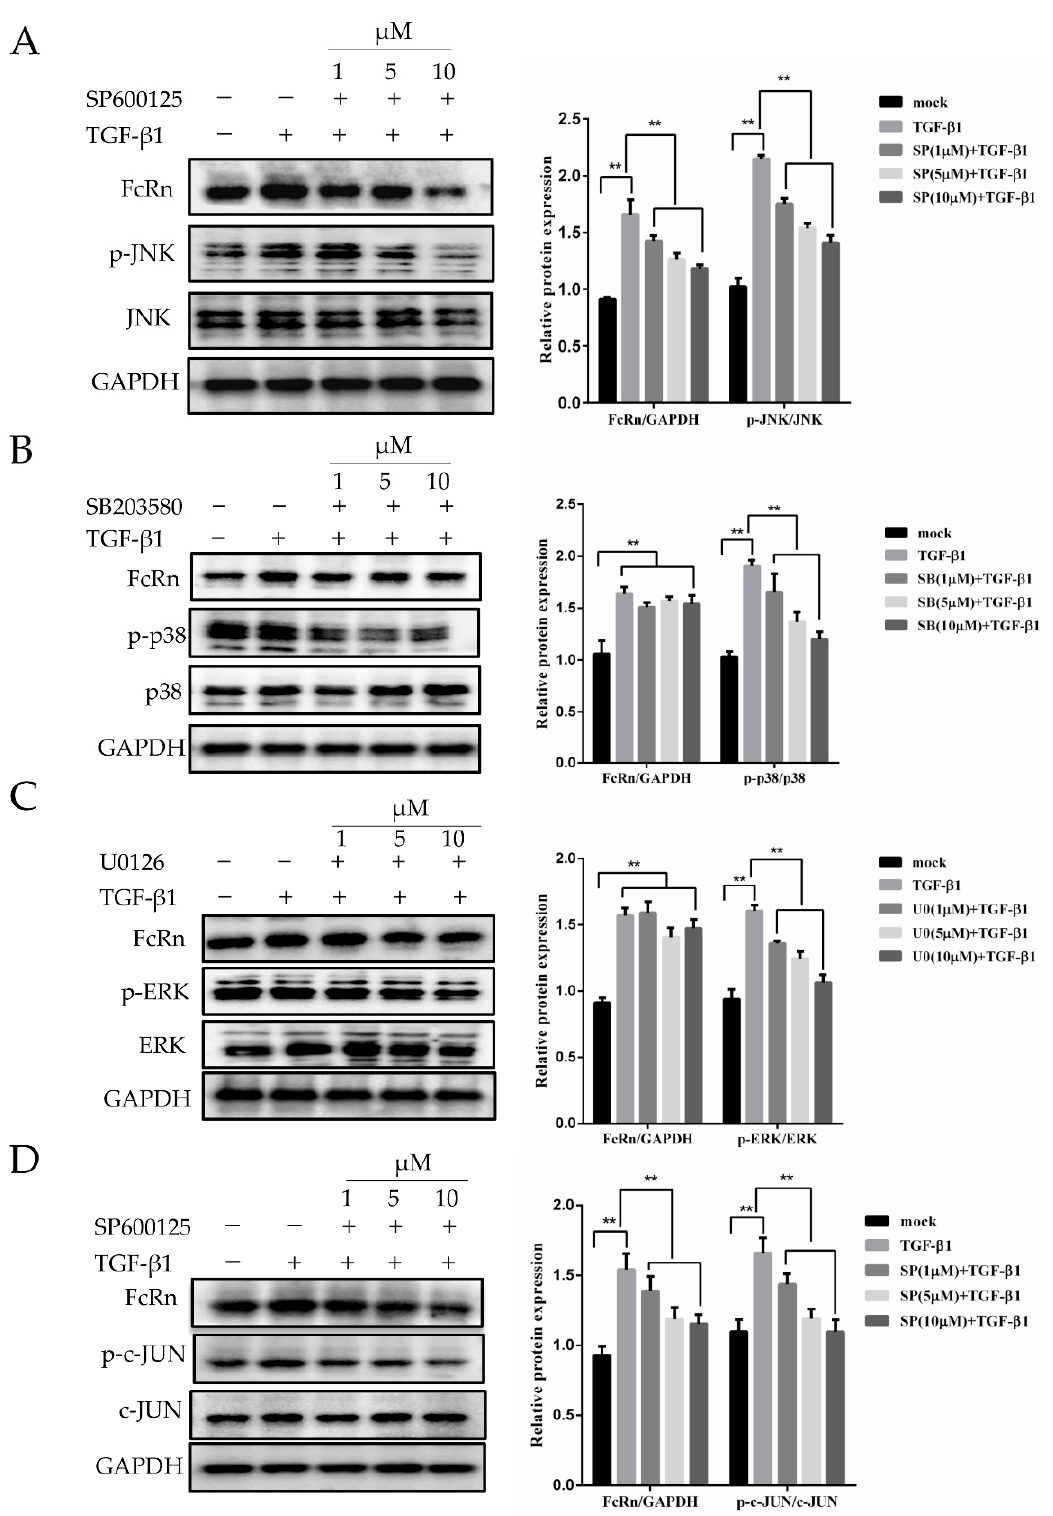
Figure 2. TGF- β 1 upregulates pFcRn expression via the JNK/MAPK and c-JUN signaling pathways. ( A ) IPEC-J2 cells were pre-treated with SP600125 (1, 5, and 10 µ M), followed by incubation with TGF- β 1 (8 ng/mL) for 12 h. IPEC-J2 cells were harvested and Western blotting was performed as described in Section 2. ( B – D ) were performed as described in ( A ) using the following inhibitors: p38 inhibitor SB203580 (1, 5 and 10 µ M), ERK inhibitor U0126 (1, 5, and 10 µ M), and JNK inhibitor SP600125 (1, 5, and 10 µ M). GAPDH was used as a loading control. The right panel represents protein band quantification determined by densitometry and normalized to GAPDH, ** p < 0.01.